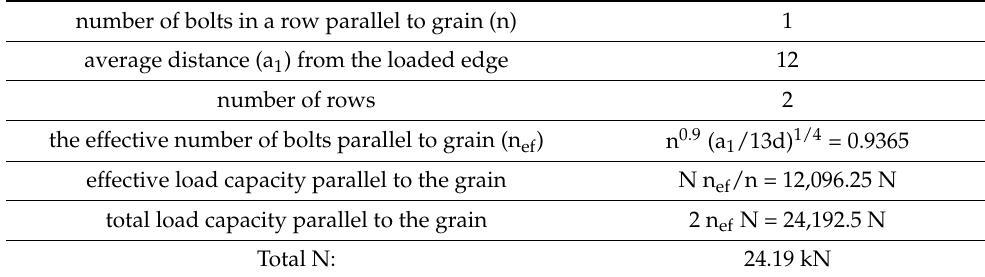
Table 2. Calculation of the total load capacity in the grain